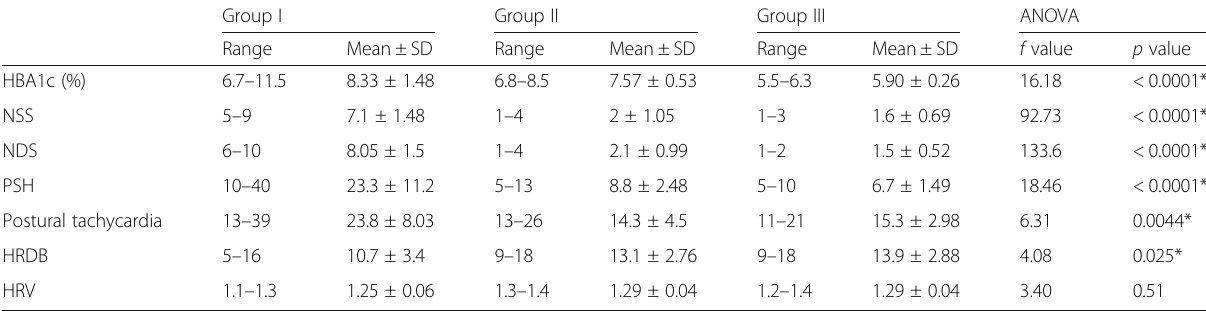
Table 1 Glycated hemoglobin, neuropathy symptom and disability scores, and autonomic nervous system assessment among diabetic neuropathy patients (group I), diabetic patients without neuropathy (group II) and healthy control (group